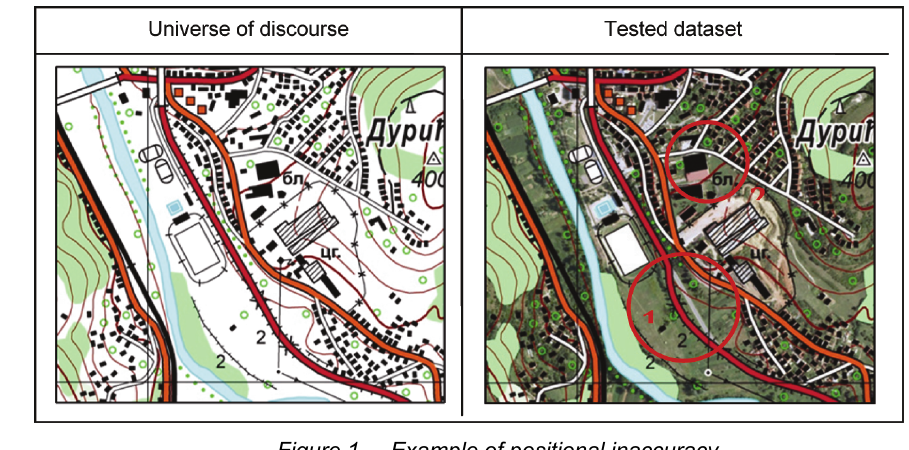
Figure 1 – Example of positional inaccuracy Рис . 1 – Пример позиционной